Question: According to the figure, is the described quantity increasing or decreasing?
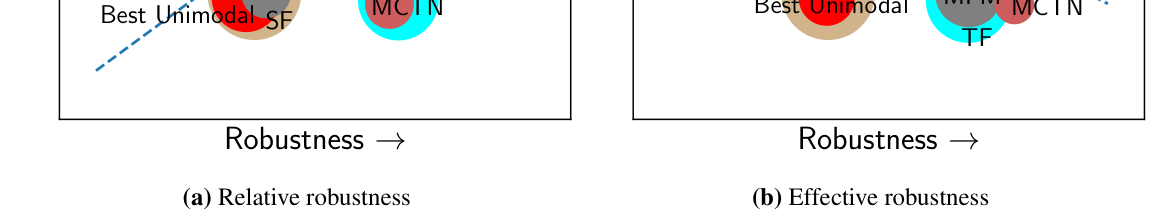
Answer: decreasing